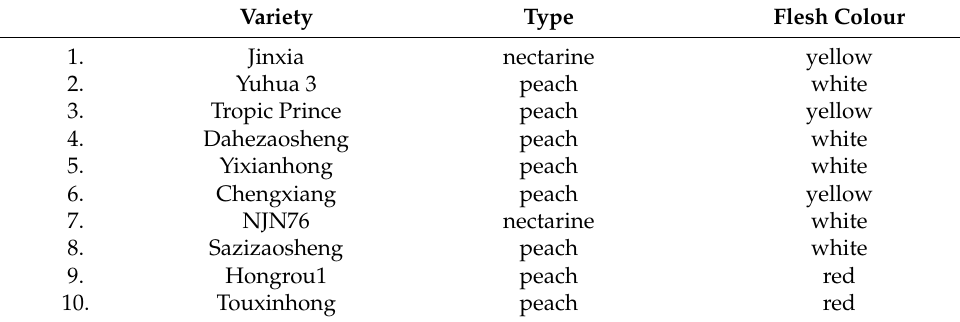
Table 1. Peach ( Prunus persica L.) and nectarine varieties used in this study. Variety